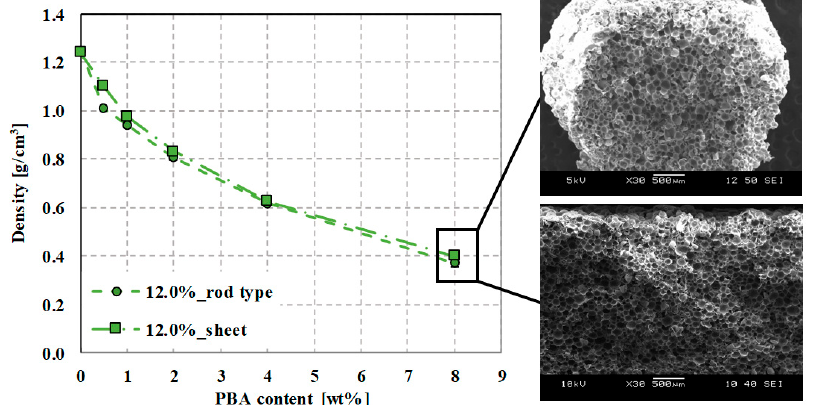
Figure 11. The density of produced rod and sheet samples at 190 °C as a function of foaming agent content.